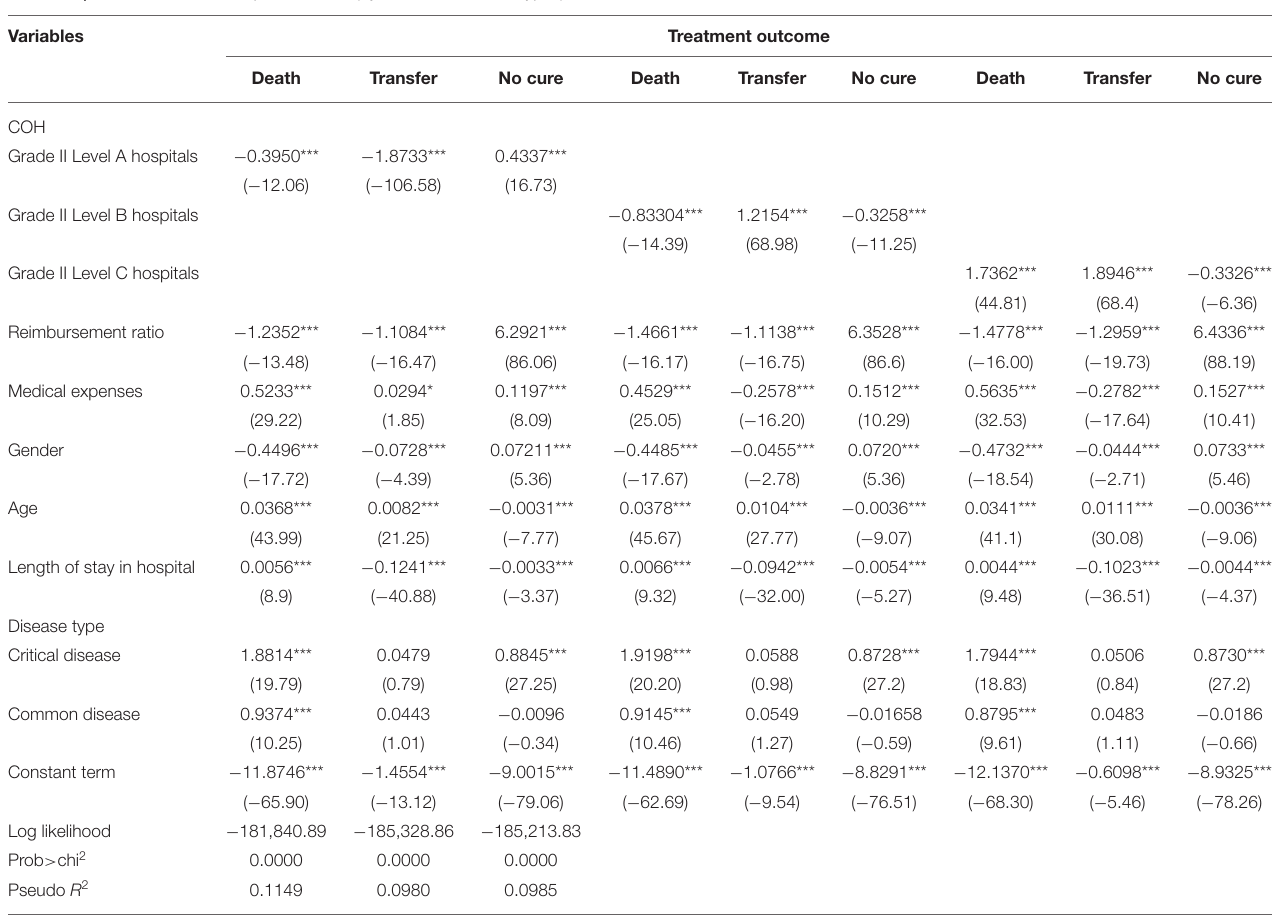
TABLE 7 | The NMNL model empirical results (by COH and disease